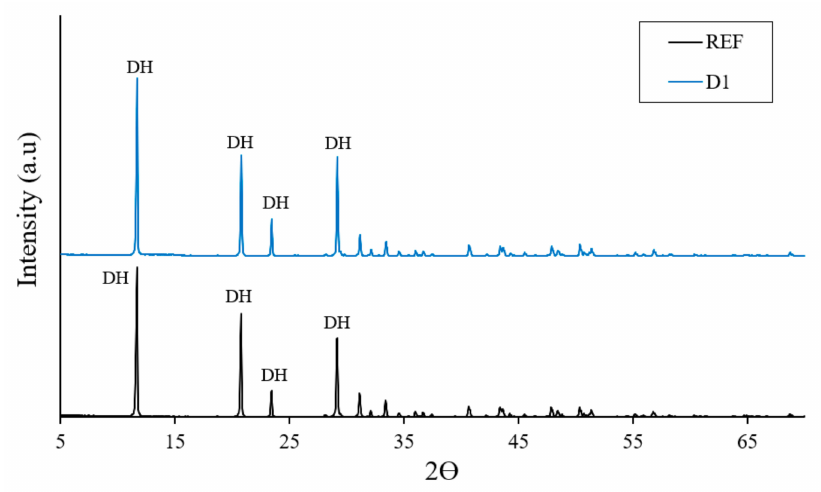
Figure 3. X-ray diffractogram of the reference specimen compared to the lightened specimen with a higher content of polymeric compound and without fibers, where DH refers to calcium sulfate dihydrate.